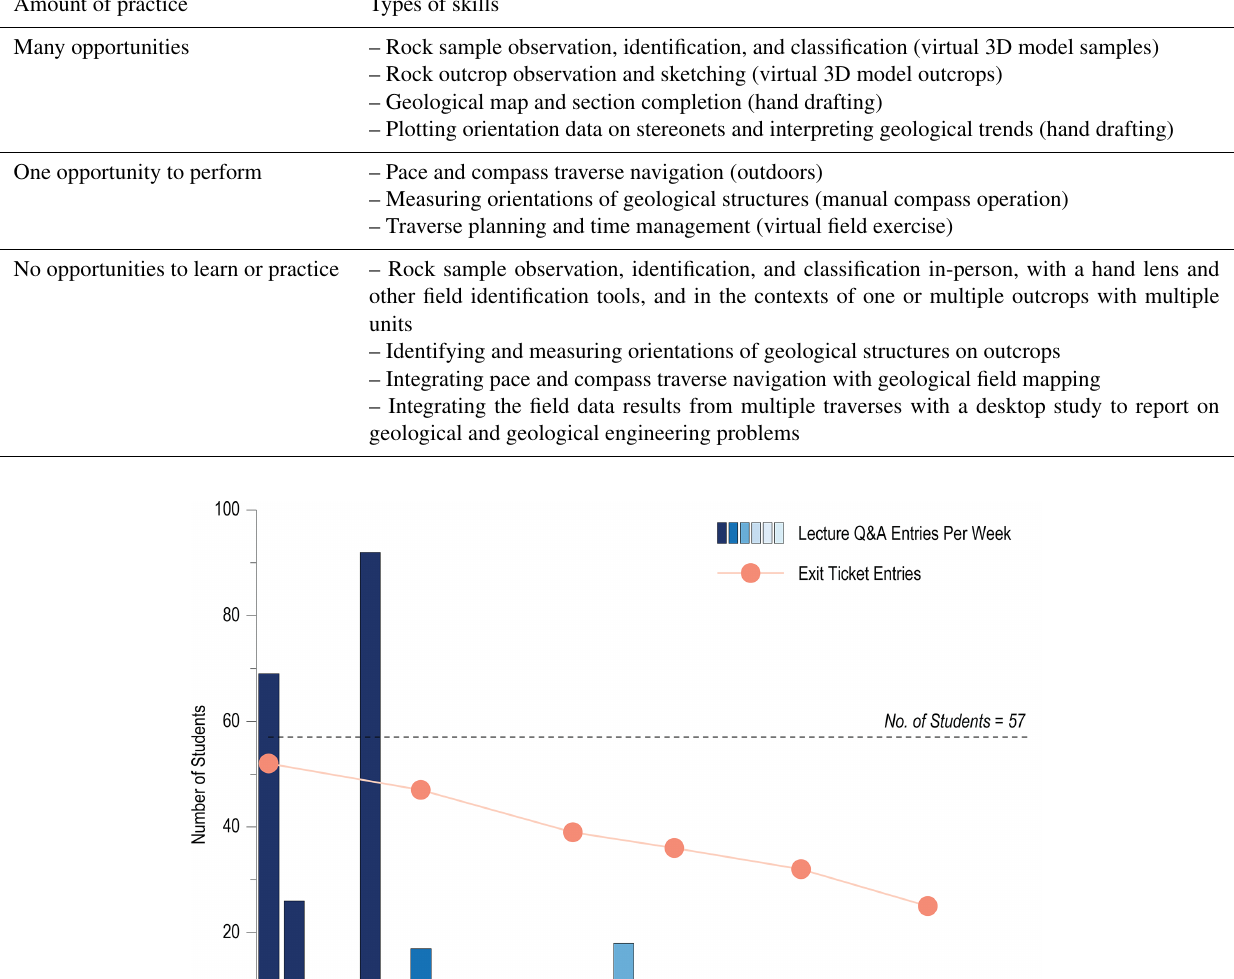
Table 5. Opportunities for skill development during GEOE/L 221 in fall 2020. Amount of practice